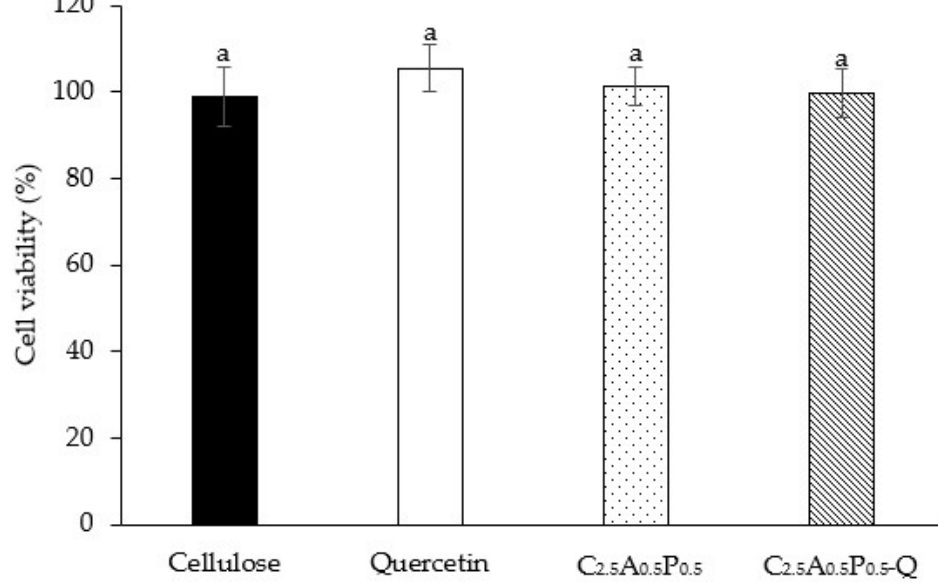
Figure 9. HaCaT cell viability after exposure to cellulose, quercetin, C 2.5 A 0.5 P 0.5 , and C 2.5 A 0.5 P 0.5 -Q. The results are demonstrated as mean ± S.D.; superscripts with the same letter ( a ) in each bar indicate insignificant difference between samples ( p > 0.05).